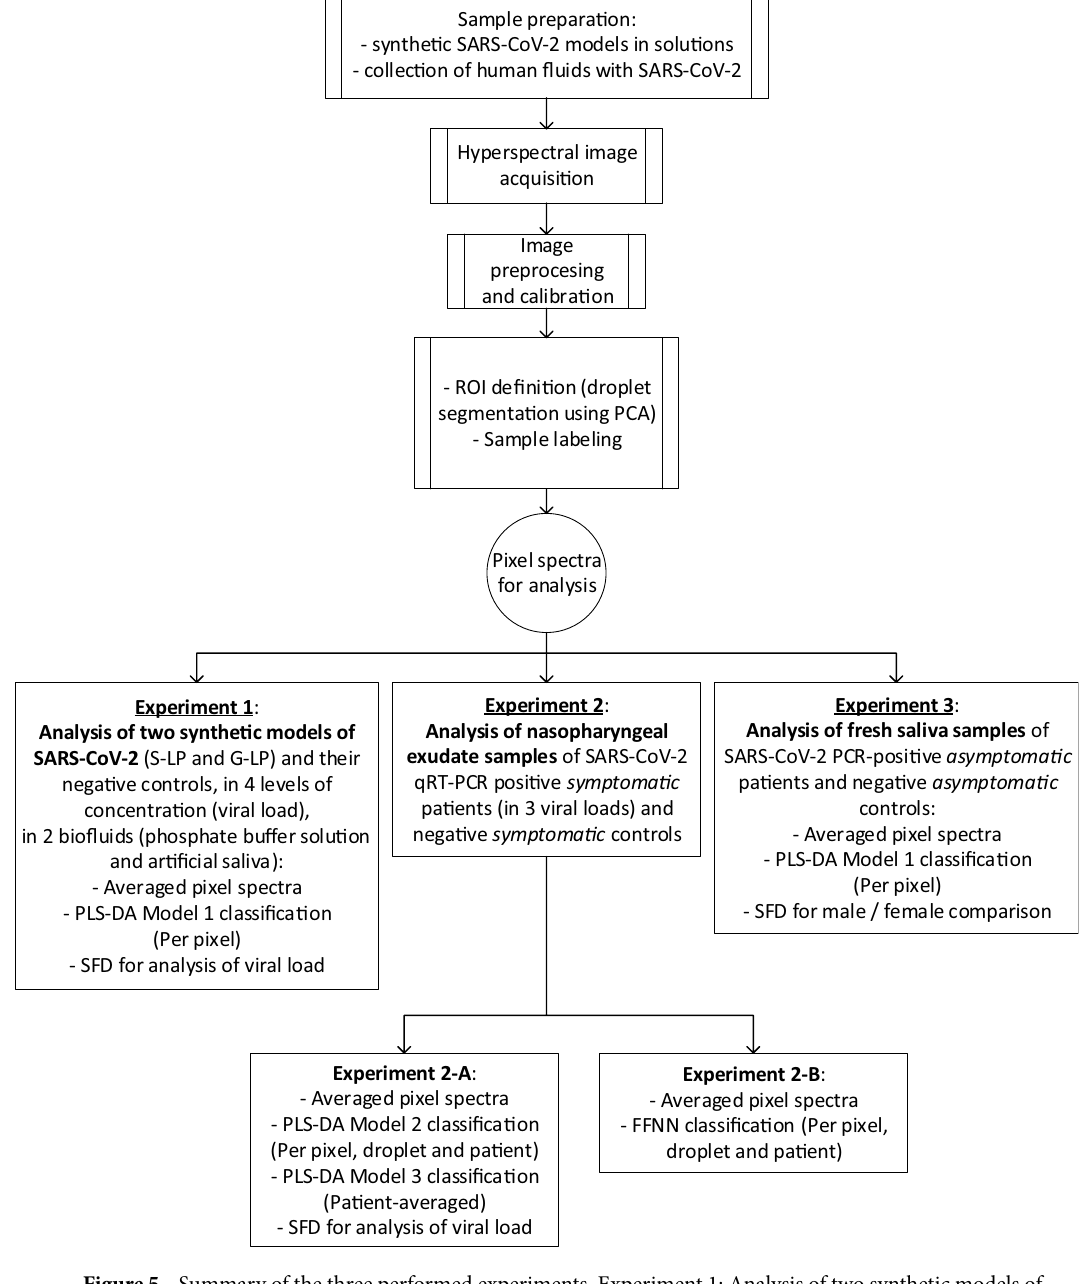
Figure 5. Summary of the three performed experiments. Experiment 1: Analysis of two synthetic models of SARS-CoV-2 (S-LP and G-LP) and their negative controls, in four levels of concentration (viral load), in two biofluids (phosphate buffered solution and artificial saliva). Experiment 2: Analysis of nasopharyngeal exudate samples of SARS-CoV-2-positive symptomatic patients (in three viral loads) and negative symptomatic controls. Experiment 3: Analysis of fresh saliva samples of SARS-CoV-2-positive asymptomatic patients and negative asymptomatic controls. ROI region of interest, PCA principal component analysis, S-LP lentiviral particles pseudotyped with the SARS-CoV-2 Spike protein, G-LP lentiviral particles pseudotyped with the vesicular stomatitis virus G protein, PLS-DA partial least square-discriminant analysis, FFNN feed-forward